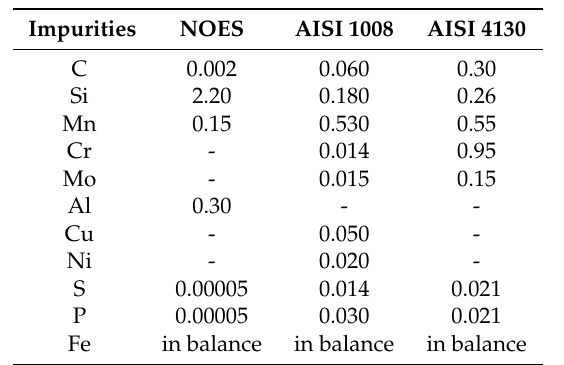
Table 1. Chemical composition in weight percent of the selected ferromagnetic steels.